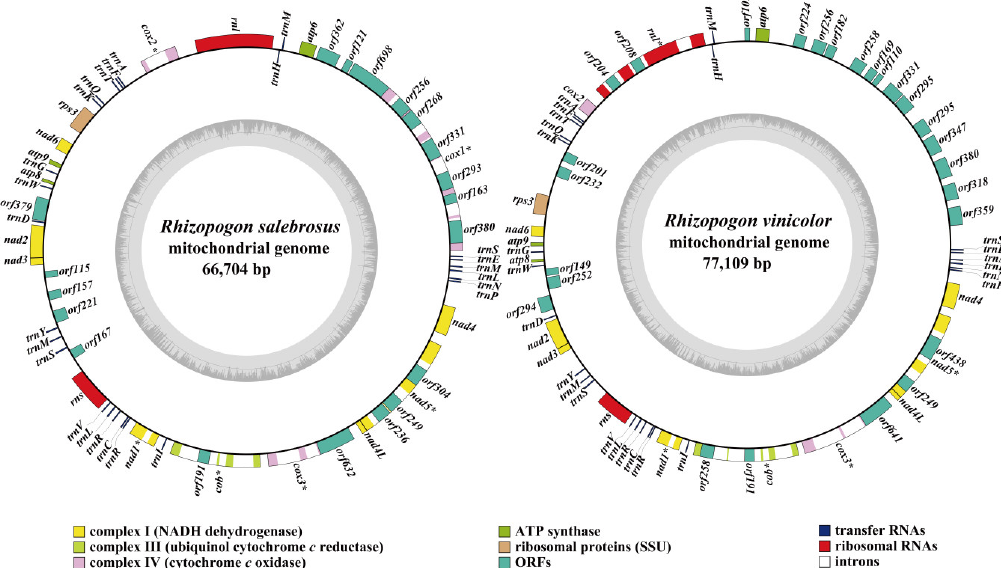
Figure 1. Circular maps of the mitogenomes of two Rhizopogon species. Genes are represented by different colored blocks. Colored blocks outside each ring indicate that the genes are on the direct strand, while colored blocks within the ring indicates that the genes are located on the reverse strand. The circle inside the GC content graph marks the 50% threshold.